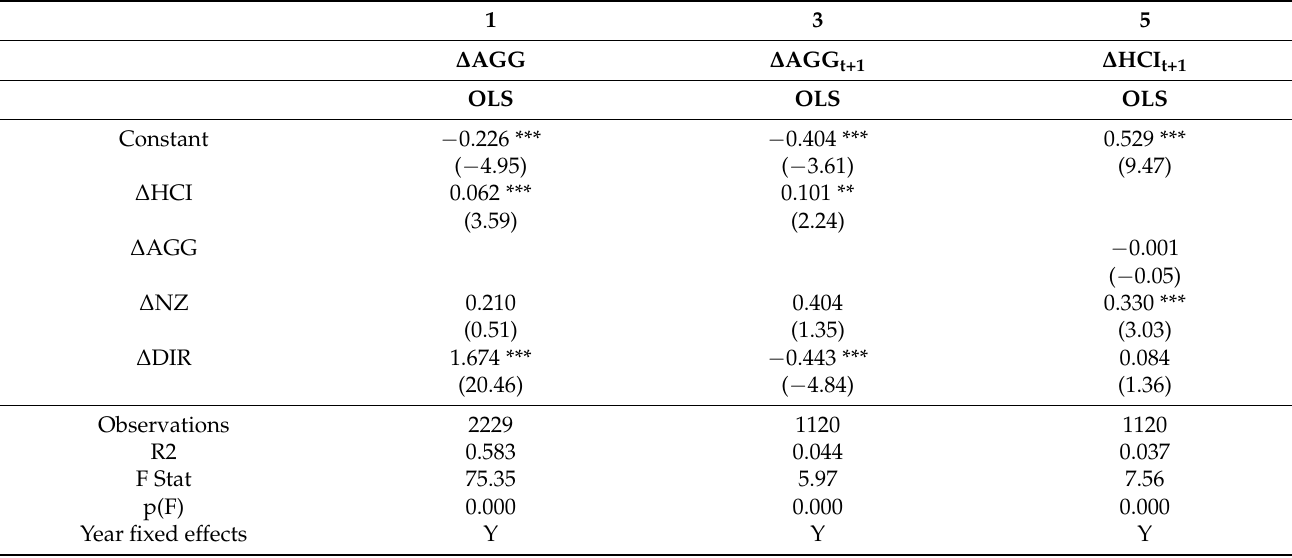
Table 6. First difference OLS